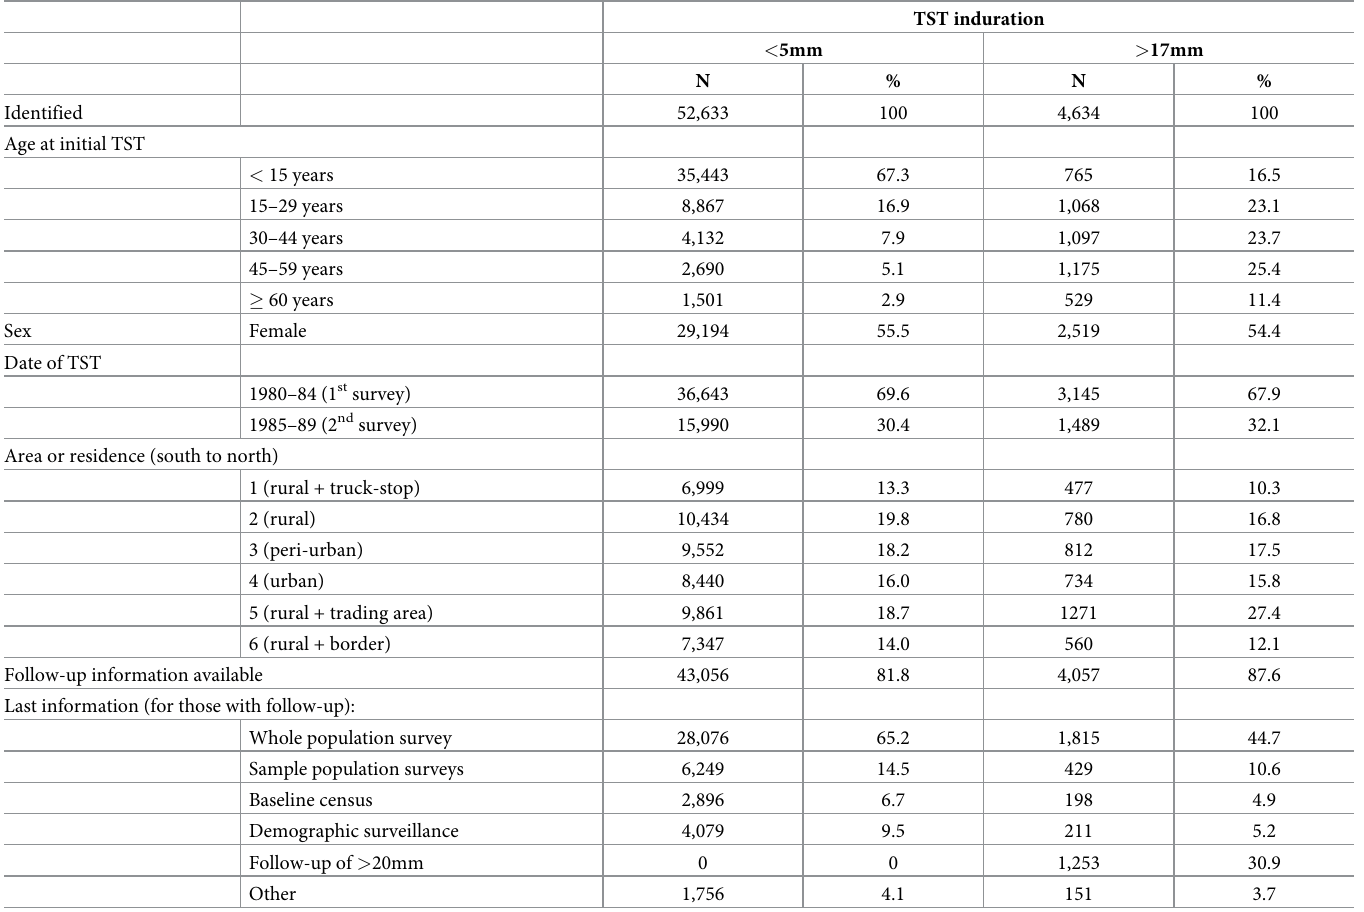
Table 1. Individuals included in the different TST induration groups with characteristics and source of follow-up